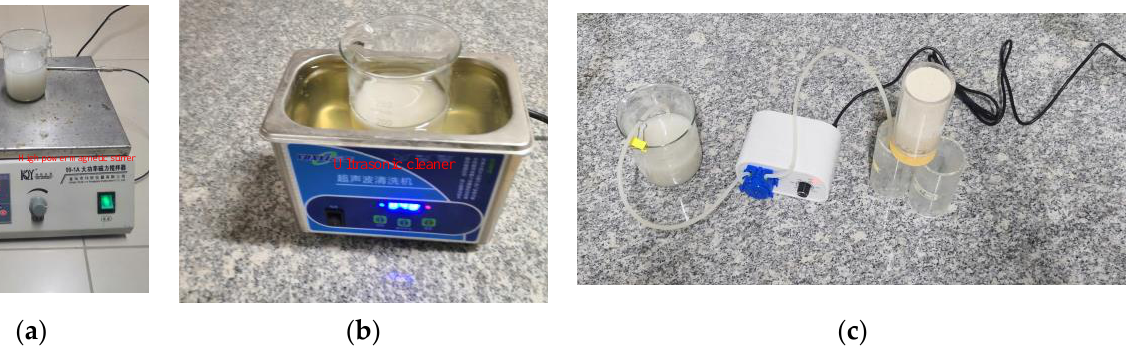
Figure 8. Specimen preparation: ( a ) magnetically stirred mixture of SiC nanowires and colloidal silica, ( b ) ultrasonic dispersion of SiC nanowires in colloidal silica, and ( c ) the SiC-nanowire-dispersed colloidal-silica seeped through sand.